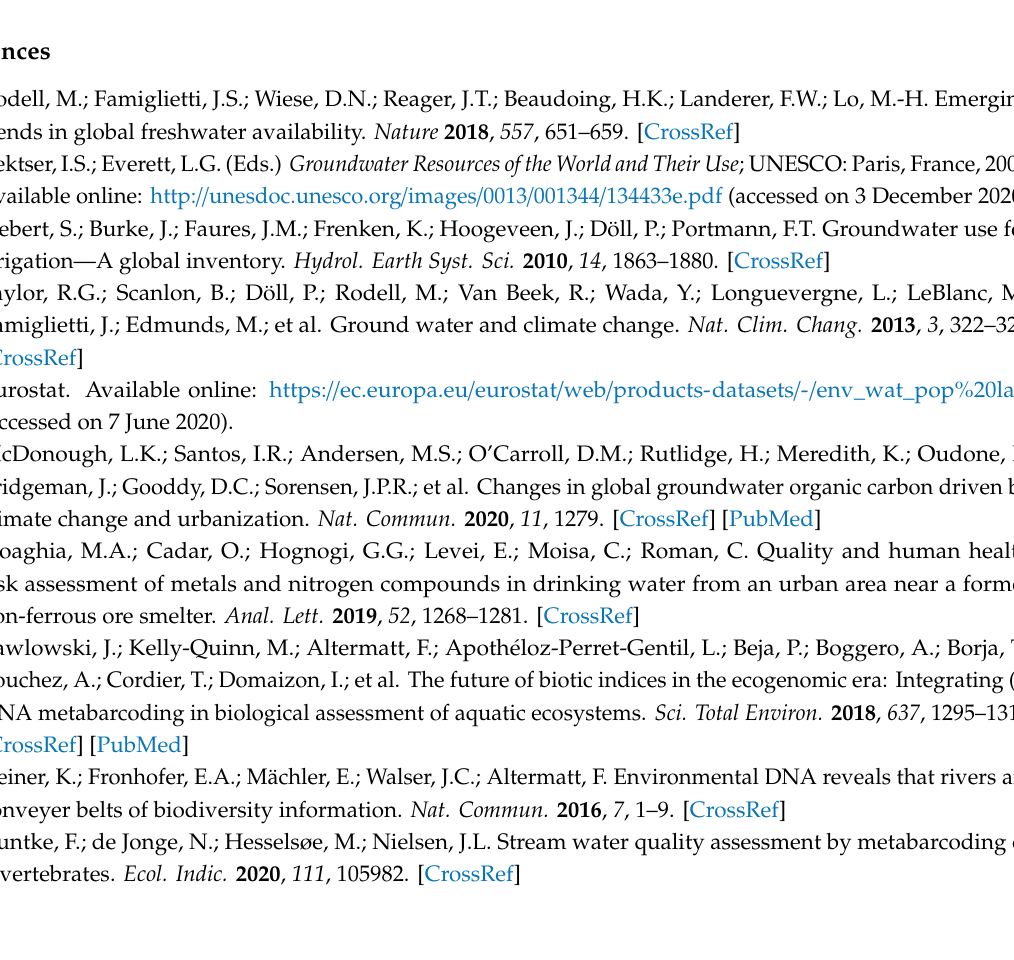
Figure S1 . The Piper diagram of the chemical elements for the studied springs; Figure S2 . The heat maps of the first 25 most abundant species (above the most abundant) in each of the studied springs, Banpotoc, Baita and Rapoltel (from left to right). Relative abundance of species was considered in the analysis; Table S1 . The relative abundance of the Bacteria phyla in the analyzed membranes, with the dominant Proteobacteria (see also Figure 3); Table S2 . Number of reads for the pathogenic bacteria for humans and animals found in the three studied karstic